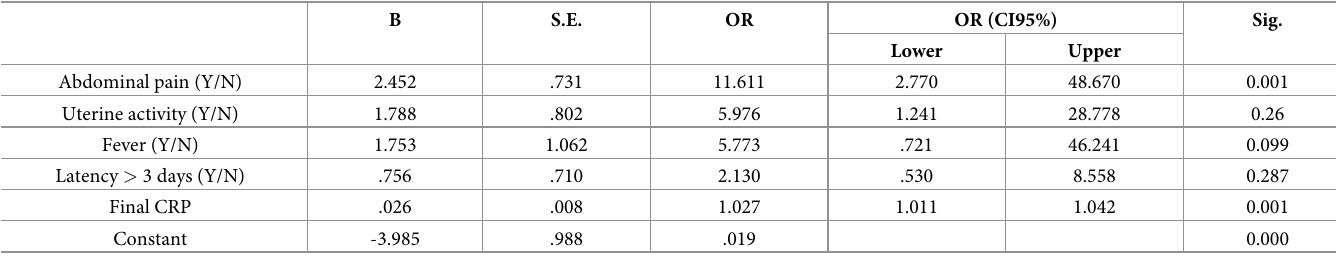
Table 4. Predictive model of HCA obtained through forward conditional binary logistic regression, controlled for latency > 3 days. B S.E. OR OR (CI95%) Sig.